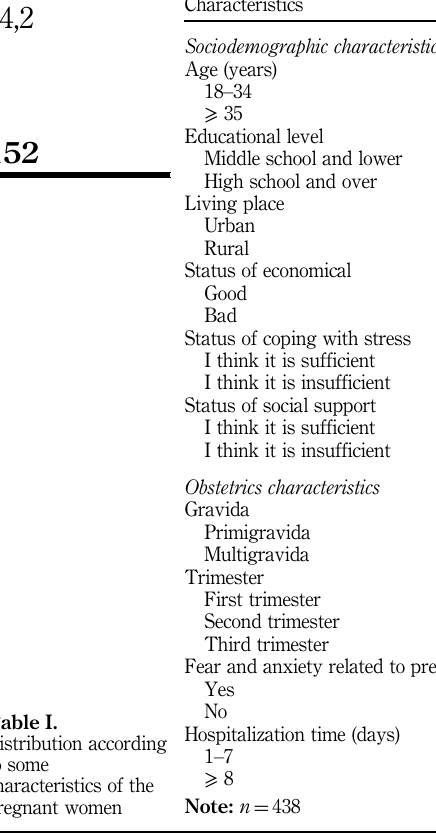
insufficient, and who were hospitalized for ⩾ 8 days ( p o 0.05). The mean scores of the extroversion/introversion and consistency/inconsistency sub-dimensions were statistically significantly higher in the pregnant women who were middle school graduates or higher ( p o 0.05). The mean scores of the extroversion/introversion and emotional stability/ neuroticism sub-dimensions were statistically significantly higher in the multigravida participants ( p o 0.05). The mean scores of the emotional stability/neuroticism and consistency/inconsistency sub-dimensions were high in pregnant women experiencing fear and anxiety related to pregnancy/labor ( p o 0.05). None of the three sub-dimension mean scores of the CPS were statistically different in terms of the place of residence, perception of economic status and gestational trimester ( p o 0.05) (Table V).